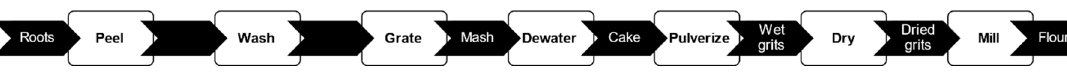
Figure 1. Steps used to process cassava root into flour.